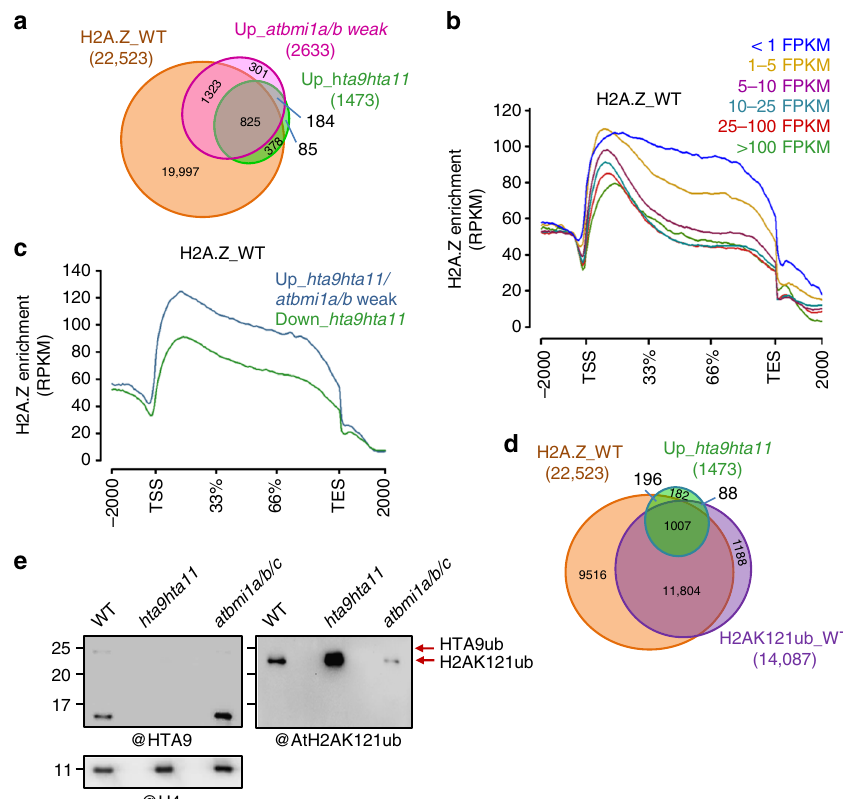
Fig. 3 Overlap between upregulated genes in hta9hta11 and atbmi1a/b . a Venn diagram showing the number of overlapping genes when comparing H2A.Z- enriched genes in wild-type (WT) seedlings (H2A.Z_WT), upregulated genes in hta9hta11 , and upregulated genes in atbmi1a/b weak mutant. b Metagene plots showing H2A.Z levels over different subsets of genes grouped according to their expression levels (indicated in FPKM (fragments per kilobase of exon and million mapped reads) and different colors). TSS transcription start site, TES transcription stop site. c Metagene plots showing H2A.Z enrichment in WT at genes upregulated in hta9hta11 and atbmi1a/b weak mutants and at genes downregulated in hta9hta11 . d Venn diagram showing the number of overlapping genes when comparing H2A.Z-enriched genes in WT (H2A.Z_WT), H2AK121ub marked genes in WT (H2AK121ub_WT), and upregulated genes in hta9hta11 . e WB blot showing H2AK121ub and HTA9ub levels in WT, hta9hta11 , and atbmi1a/b/c (right and left panels, respectively). The blot was probed with an anti-AtH2AK121ub antibody, then stripped and re-probed with anti-HTA9 antibody. Arrows indicate the bands recognized by the antibody. The same blot was probed with anti-H4 antibody for loading control (bottom panel). Source data of Fig. 3e are provided as a Source Data fi